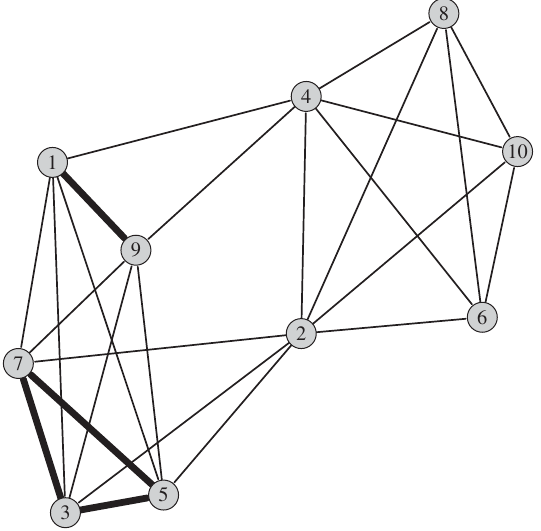
FIG. 1. Simple example graph. When two problems are in the same category more than once (problems 1 and 9 as well as problems 3, 5, and 7 in this example), the edges drawn between those two corresponding vertices are thicker. The line width of each edge was taken proportional to the square of the number of connections between two vertices.